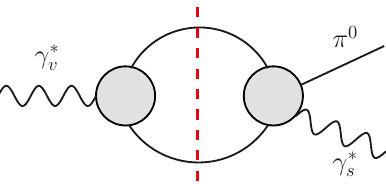
Figure 4. Two-body unitarity relation for (cid:13) (cid:3) (cid:13) (cid:3) (cid:25) 0 . The gray blobs represent the pion vector v ! s form factor and the (cid:13) (cid:3) 3 (cid:25) amplitude, respectively, and the solid lines pion intermediate s !